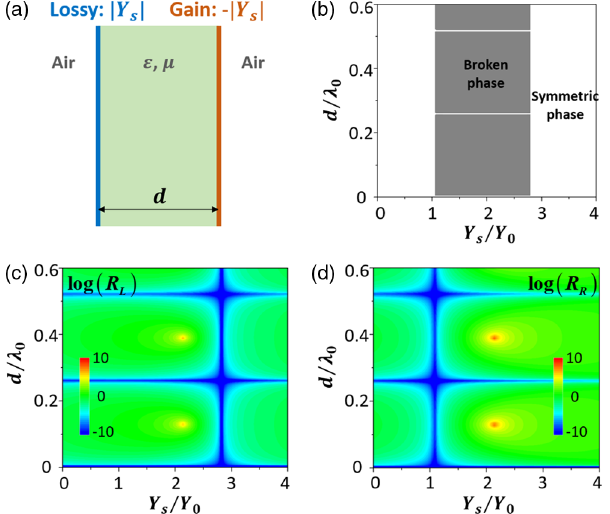
FIG. 1. (a) Illustration of the PT -symmetric system composed of a slab with relative permittivity ε and relative permeability μ sandwiched by PT -symmetric metasurfaces with surface admit- tance (cid:3)j Y s j . (b) Phase diagram for incident angle θ ¼ 30 ° under TE polarization. The white and gray regions denote the sym- metric and broken phases, respectively. (c,d) Reflectance as functions of d= λ 0 and Y s =Y 0 for (c) left and (d) right incidence on the PT -symmetric system. The red dots are related to the zeros and poles of the scattering matrix of the PT -symmetric system. In panels (b) – (d), the parameters of the slab are ε ¼ 4 and μ ¼ 1 .